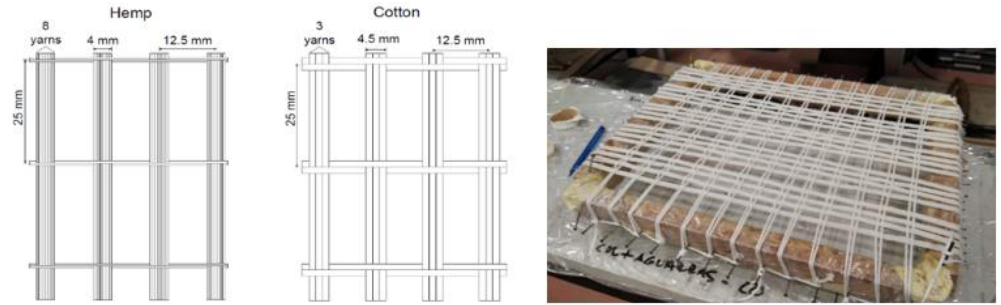
Figure 2. Meshes geometry ( left ), wooden mesh ( right ).